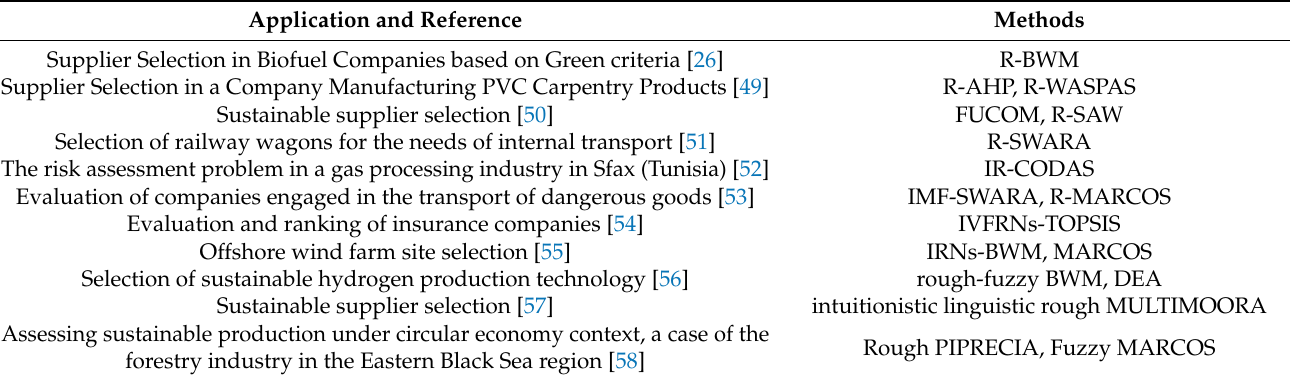
Table 1. Rough numbers—literature